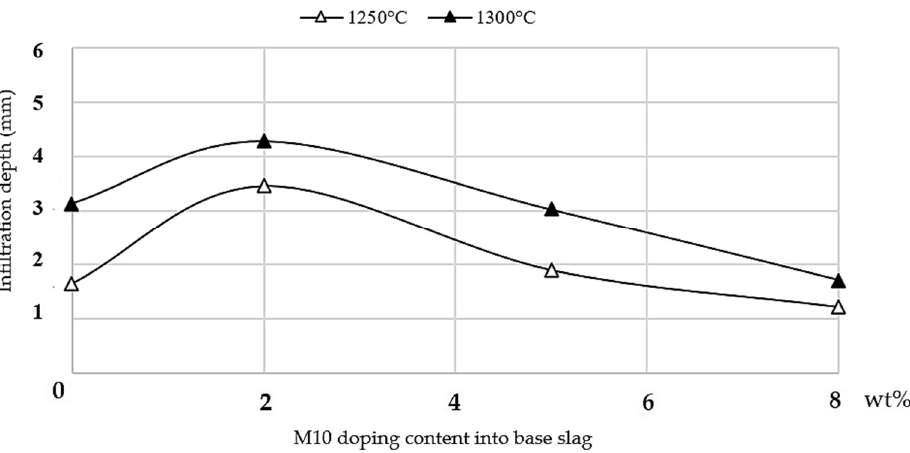
Figure 6. Infiltration depth of M10-doped slag into the refractory v/s the doping content at 1250 and 1300 °C.